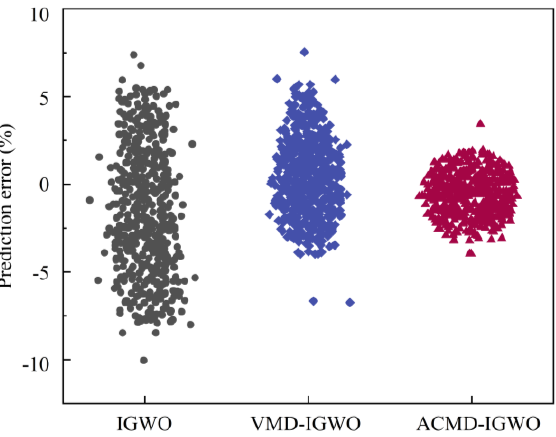
Figure 11. Prediction error distribution diagram using different decomposition methods.